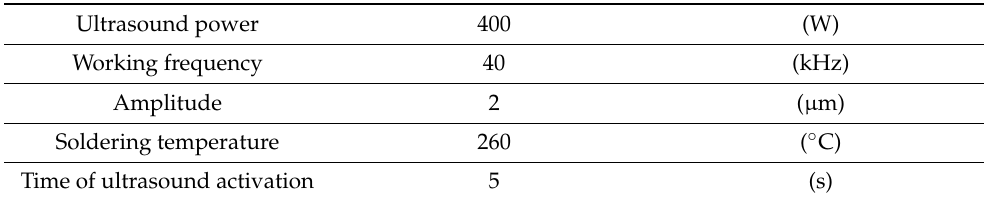
Table 2. Ultrasonic soldering parameters.